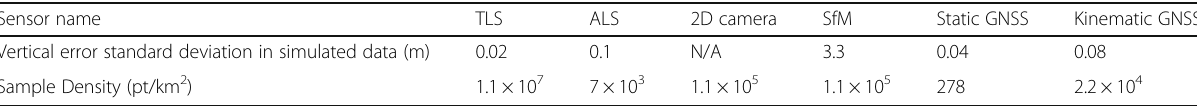
Table 1 Sensor resolution and error